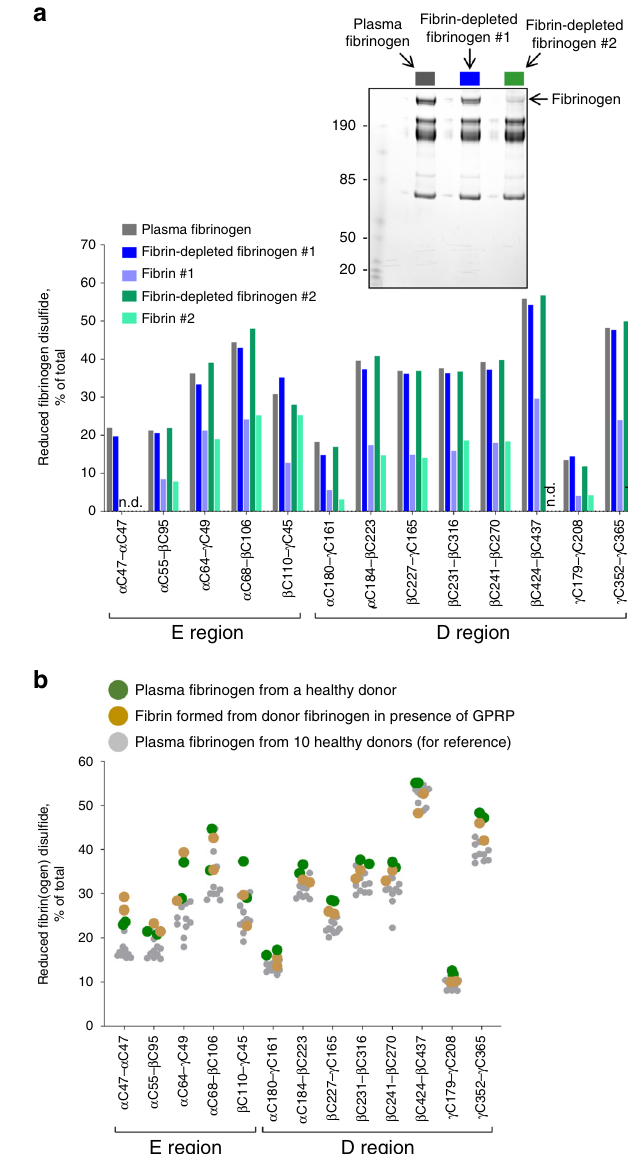
Fig. 3 Fibrinogen disul fi des form upon fi brin polymer formation. a All covalent states of fi brinogen contribute to fi brin formation. An aliquot of thrombin was added to healthy donor plasma and the fi brin polymer removed. Another aliquot of thrombin was added to the depleted plasma and the new fi brin polymer removed. At top is a Coomassie stained gel showing successive depletion of fi brinogen from the plasma. Molecular mass standards are shown in the left-hand lane. Fibrinogen concentration in the plasma was reduced 41% in the fi rst reaction and >95% in the second reaction. There was no change in the disul fi de-bonded states of fi brinogen as fi brin polymer was formed, whereas the disul fi des in fi brin polymer were more oxidized. Peptides that were not resolved in the experiment are indicated as not determined (n.d.). Source data are provided as a Source Data fi le. b Fibrin polymerization is required for disul fi de bonds to form. Thrombin was added to a male and a female healthy donor plasma (green symbols) and the resulting fi brin (brown symbols) was prevented from polymerizing by the tetrapeptide, GPRP. There is no oxidation of disul fi de bonds in the fi brin if polymerization is prevented. The redox states of ten healthy donor fi brinogens are shown for reference (gray symbols). Source data are provided as a Source Data fi